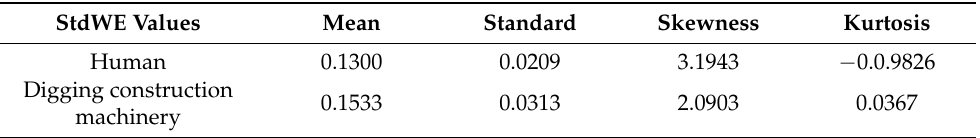
Figure 11. Comparison of StdWE values of the 10 groups of radar data for human and digging construction machinery positions. Table 4. Comparison of statistical parameters for StdWE between humans and digging construction